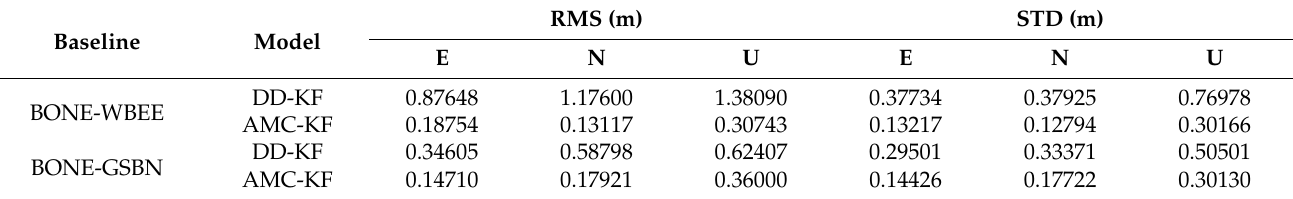
Table 5. The RMS and STD of position error on the ENU